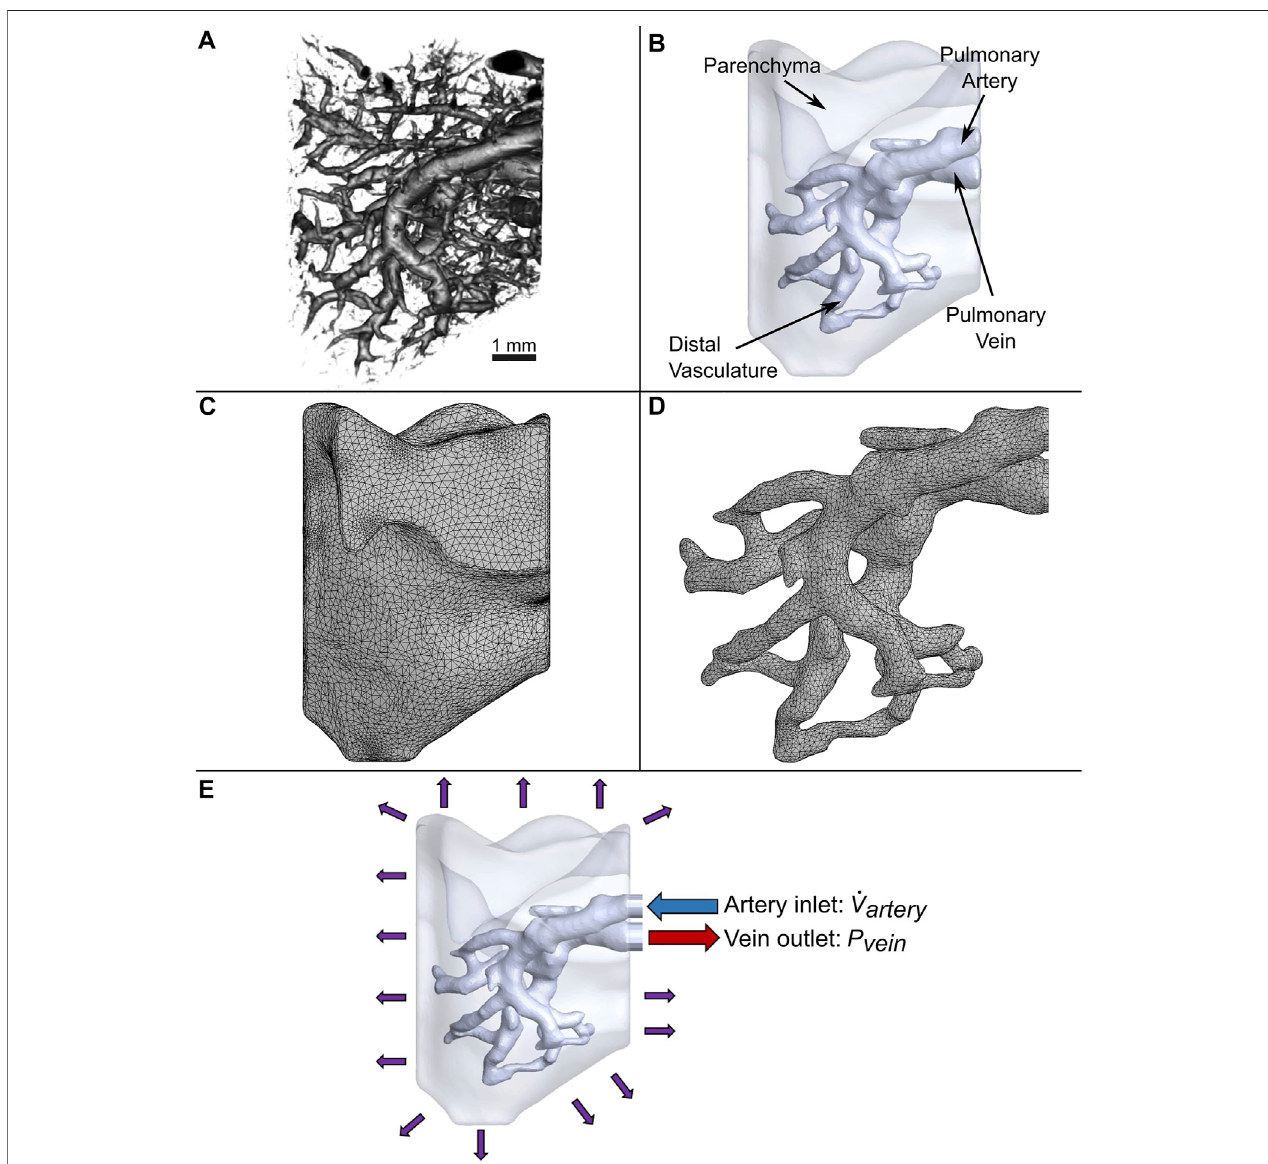
FIGURE 1 | Generation of the computational domain for CFD simulations. (A) 3D micro-CT reconstruction of a native mouse lung. (B) Simpli fi ed model of vasculaturesurrounded byparenchymamodeledasabulkuniformporousmaterial. (C) Tetrahedralmeshoftheparenchymaand (D) vasculature. (E) Appliedboundary